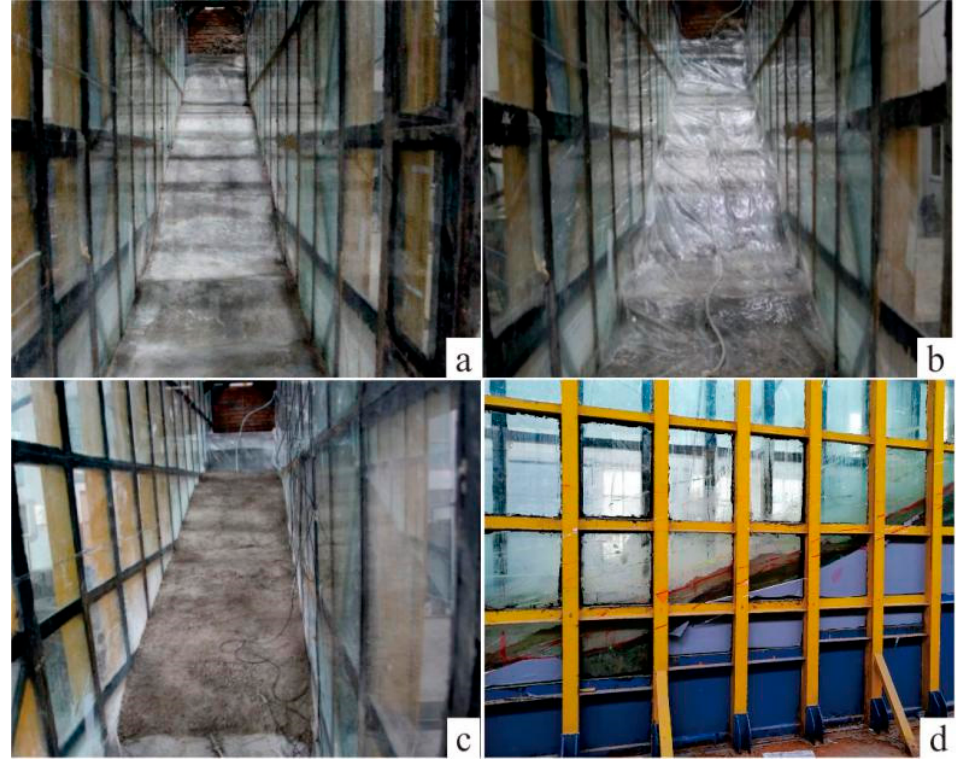
Figure 6. Monitoring layout of the test models.